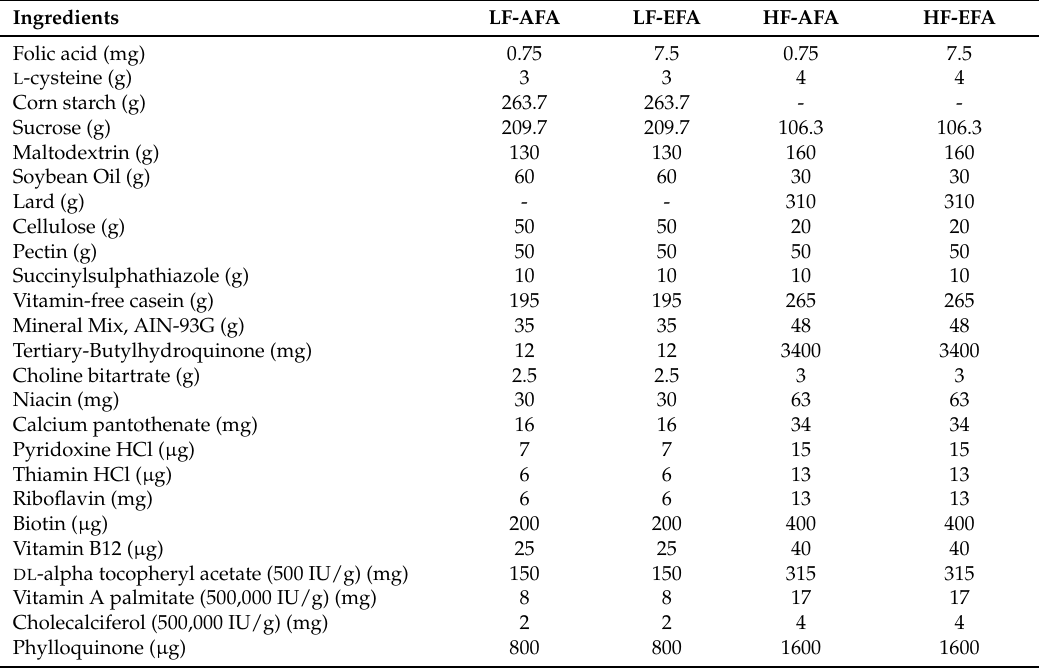
Table 1. Composition of diets (per kilogram